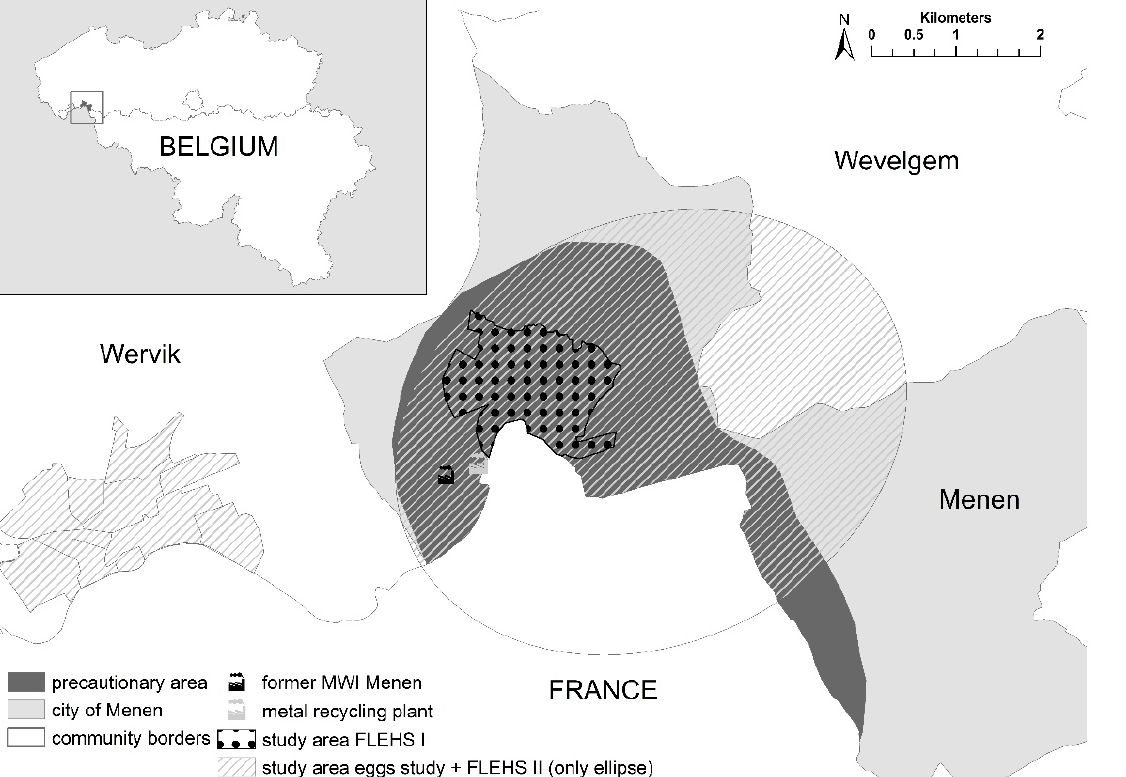
Figure 2. Geographic location of the FLEHS I study area (dotted area), the FLEHS II study area (Flemish territory within the ellipse), the study area of the eggs study (Flemish shaded areas in the ellipse and in Wervik), the precautionary area (dark grey), the (former) municipal waste incinerator (MWI) and the metal recycling plant in the region of Menen, Flanders, Belgium.